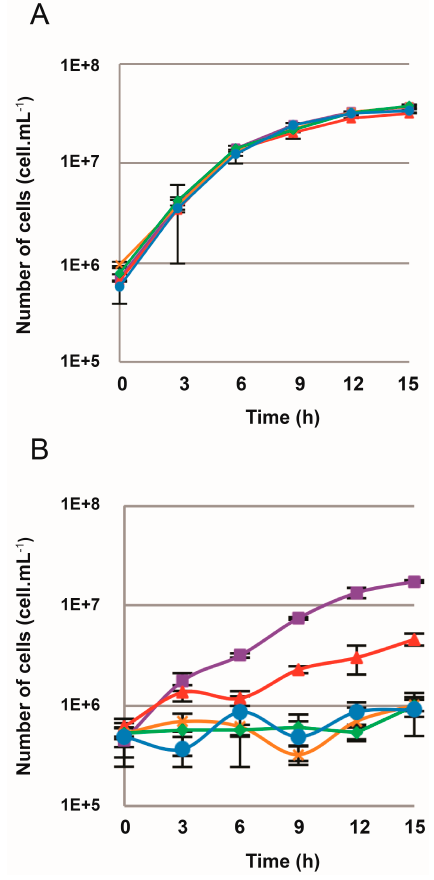
Figure 5. Growth curves of: T. barophilus ∆ TERMP_00517 ( A ); and T. barophilus ∆ TERMP_00517 ::pUPH- Growth curves of: T. barophilus ∆ TERMP_00517 ( A ); and T. 1 ( B ). The strains were cultivated at 85 °C and 0.1 MPa in TRM medium containing different